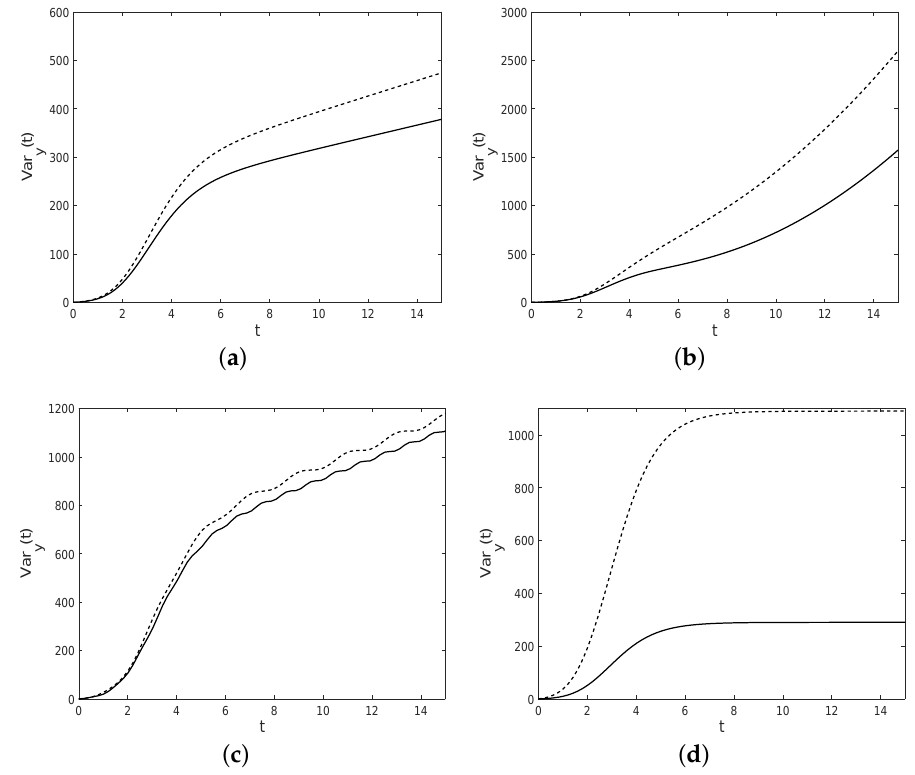
Figure 8. For y = 1, C = 10, the variance Var y ( t ) is plotted for the cases of Table 6. In case ( a ): A = 0.6 (solid) and A = 0.8 (dashed). In case ( b ): A = 1, B = 1, t 0 = 5 (solid) and t 0 = 1 (dashed). In case ( c ): A = 2, B = 2, Q = 1 (solid) and Q = 2 (dashed). In case ( d ): A = 1 (solid) and A = 5